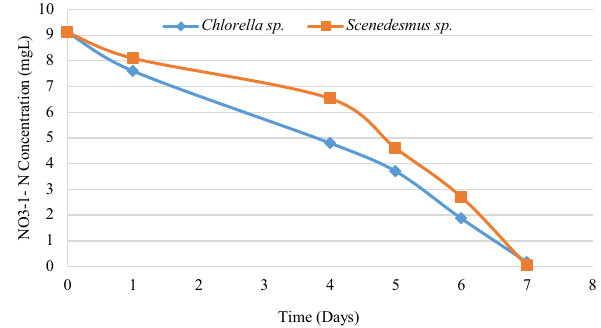
Fig. 6 Nitrate-nitrogen reduction by isolated microalgae